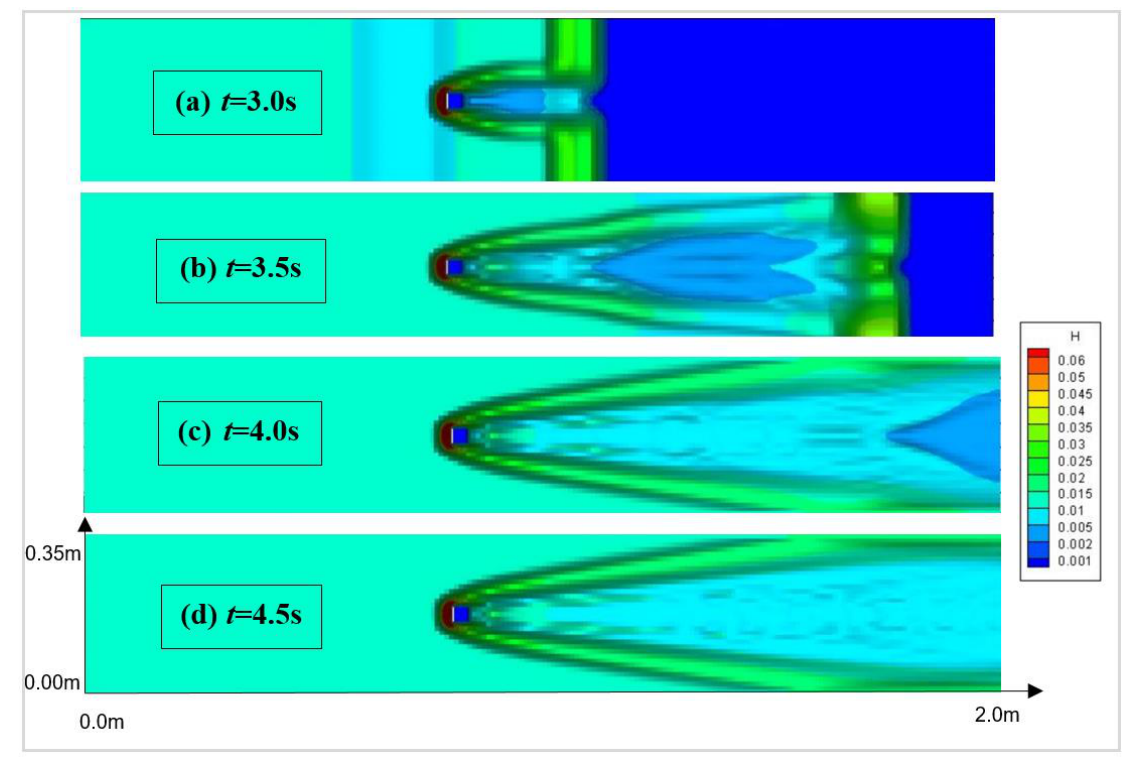
Figure 2. Simulated flow process of a uniform granular stream hitting a square obstacle with a side length of 0.04 m: ( a ) t = 3.0 s, ( b ) t = 3.5 s, ( c ) t = 4.0 s, and ( d ) t = 4.5 s (unit: m).